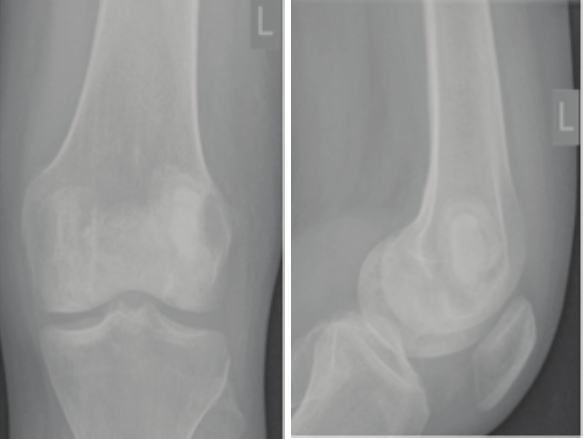
Figure 13: Antero-posterior and lateral plain radiograph at 4 months demonstrating further circumferential resorbtion of CERAMENT and filling with new bone in the course of the Gaucher disease.